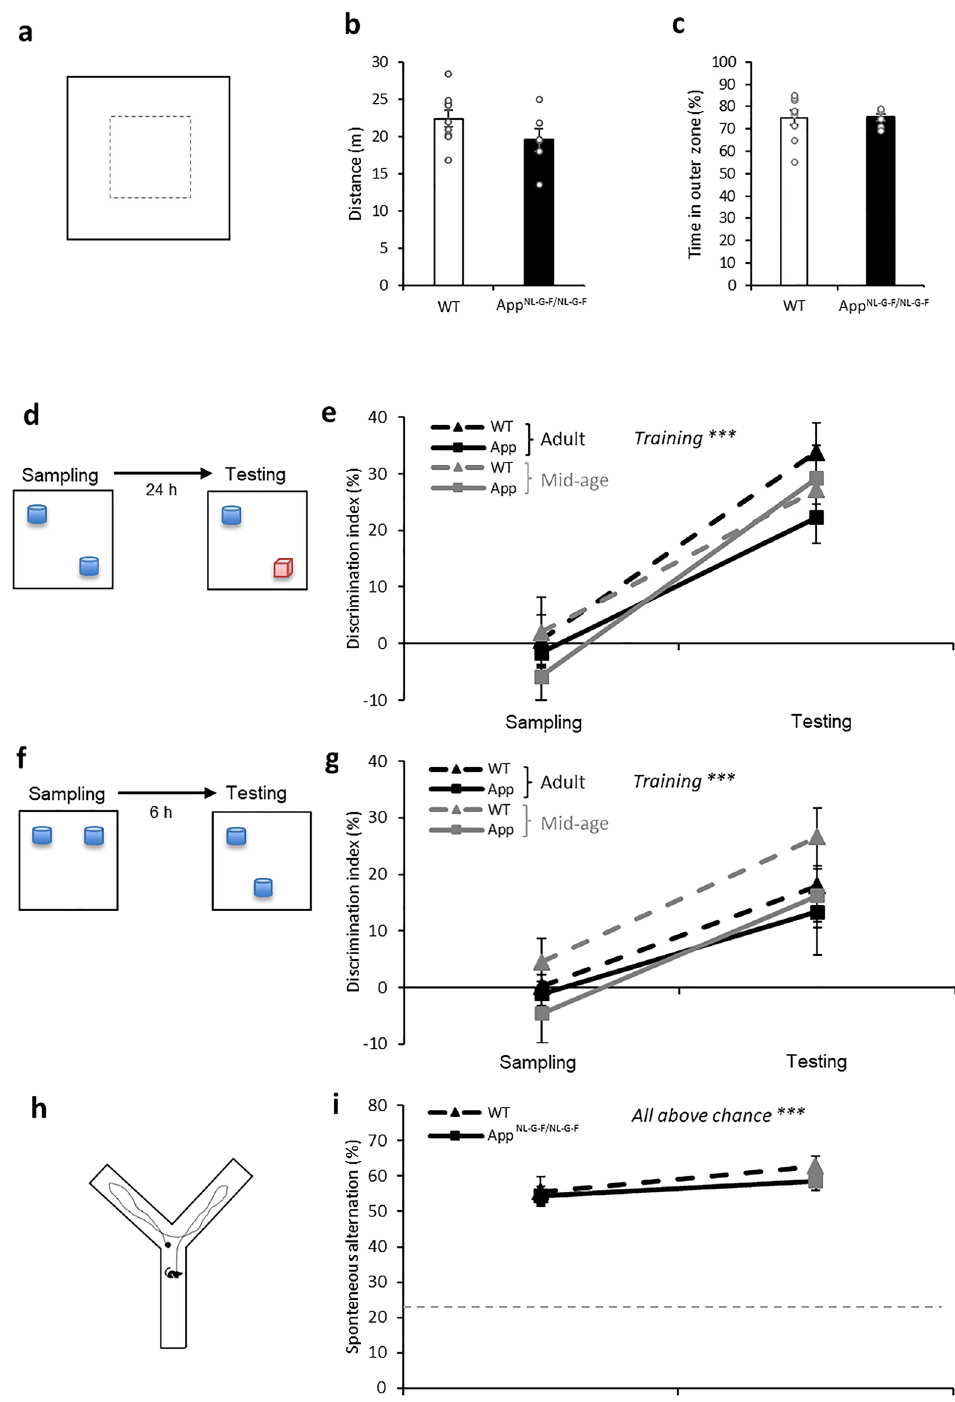
Figure 4. Behavioral results for the open field, novel object recognition (NOR), novel object location (NOL) tasks, and the Y-maze. ( a ) A schematic of the open field. ( b ) Distance travelled was comparable between groups in adulthood. ( c ) Time spent in the outer zone of the box was comparable between groups in adulthood. ( d ) A schematic of the NOR task. ( e ) Learning of NOR led to significant increase in discrimination index from training to testing (p < 0.0001), while the genotype effect, aging effect, and interactions were not significant. ( f ) A schematic of the NOL task. ( g ) Learning of NOL recognition led to significant increase in discrimination index from training to testing (p < 0.0001), while the genotype effect, aging effect, and interactions were not significant. ( h ) A schematic of the Y-maze. ( i ) Spontaneous alternation in the Y-maze was not affected by genotype. It was significantly above chance in both groups and at both ages (all p < 0.001). All data presented as mean ± SEM. ***p <